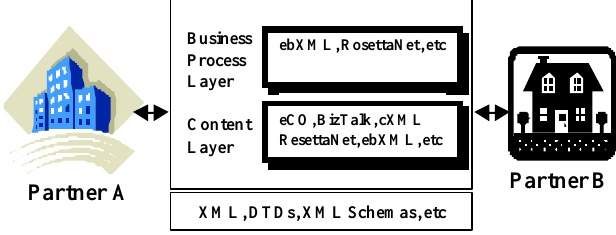
Figure3. XML Based EAI Framework